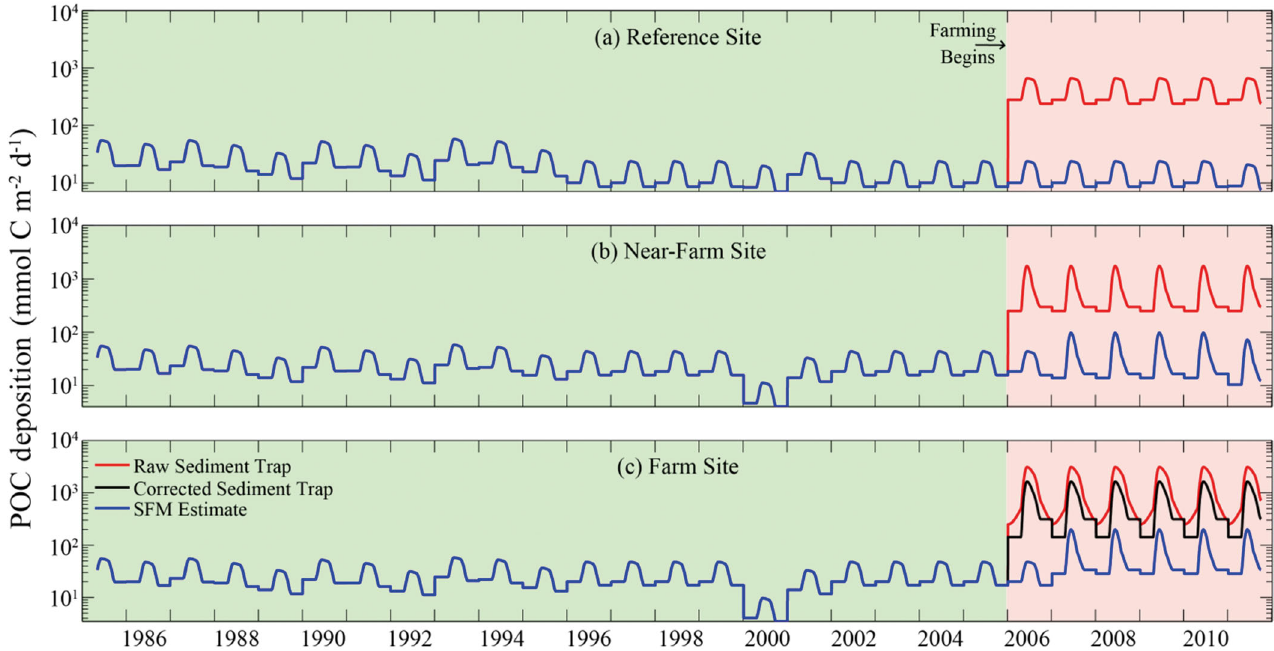
Fig. 3. Time-series (1985−2011) of particulate organic carbon (POC) deposition to sediments at (a) reference, (b) near-farm, and (c) farm sites. Green and red shading indicates pre- and post-oyster farming periods, respectively. Red line: uncorrected raw sediment trap estimates, black line: farm site sediment trap estimates corrected for resuspension, blue line: deposition estimated by sediment flux model (SFM) by fitting deposition to the observed sediment–water NH 4+